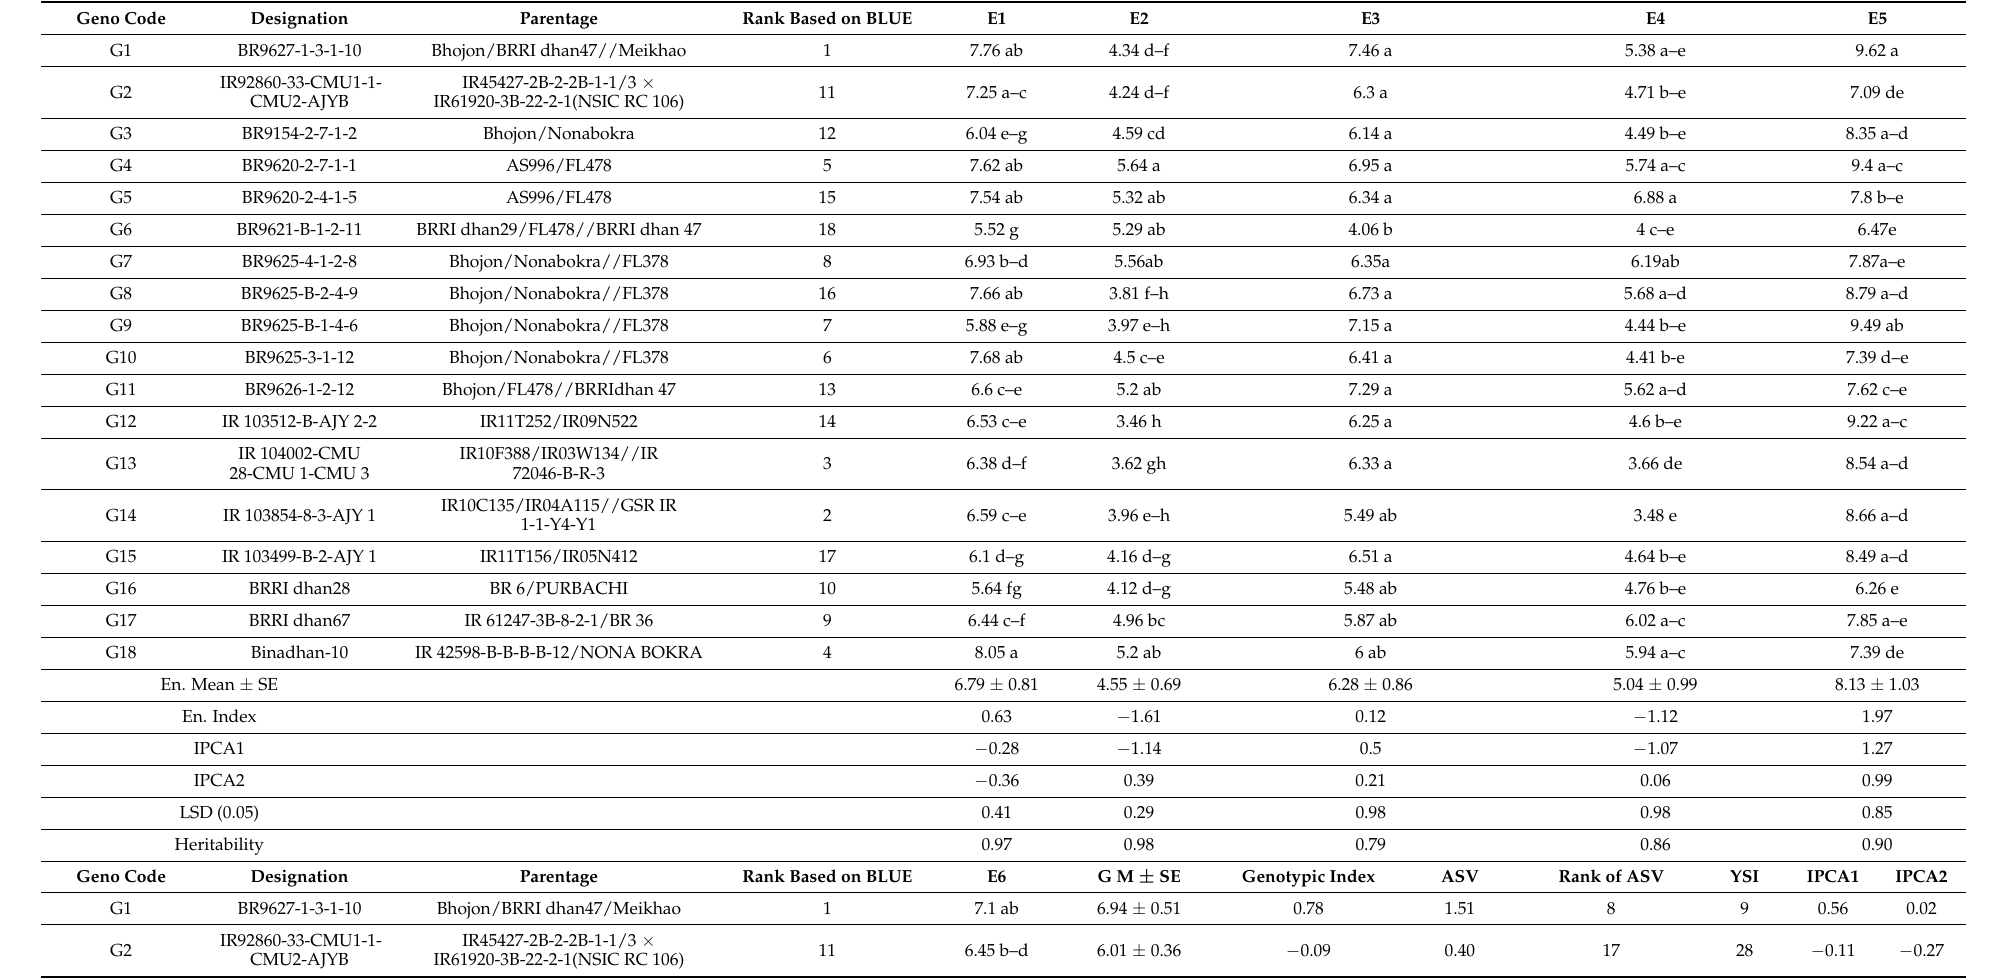
Table 3. Mean grain yield, AMMI Stability Value (ASV), yield stability index (YSI), Rank based on Best Linear Unbiased Estimation (BLUE), and Rank of ASV of 18 rice genotypes in six testing